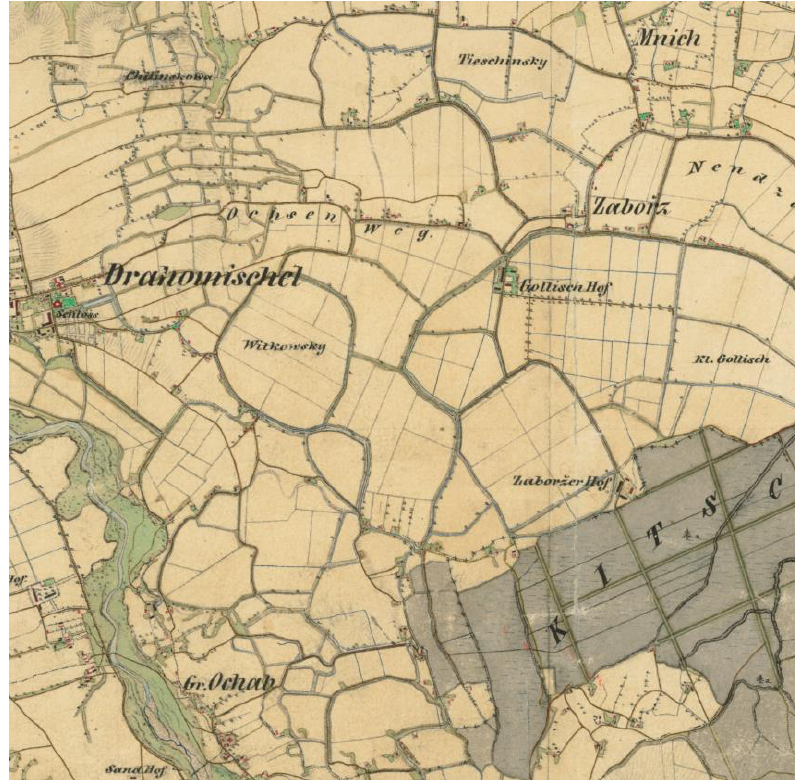
Fig. 5. A complex of several dozen ponds in the area of the Drogomyśl and Ochaby Wielkie settlements, 1763–1764 (according to Ubersicht der Militar… 1839-1840, original scale